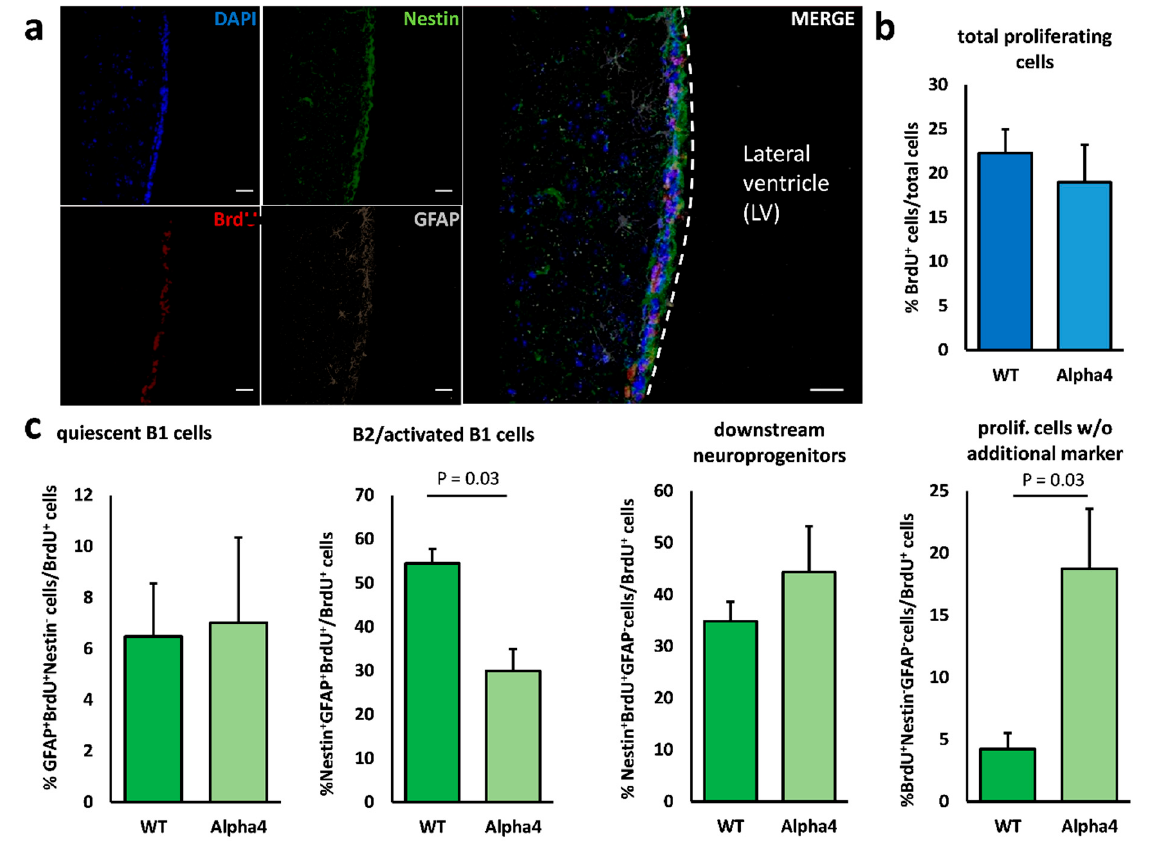
Figure 2. Neurogenesis in the V–SVZ of the L’S hypersensitive α 4* nAChR mouse. ( a ) Representative fluorescence image of the ventricular–subventricular zone lining the lateral ventricle. Daily BrdU injections over 3 days labelled proliferating cells (red). To differentiate between the various cell types within the V–SVZ, quadruple immunostainings revealed GFAP + /nestin − (grey) quiescent type B1 cells, nestin + /GFAP − (green) type A and C cells (downstream neuroprogenitors) and GFAP + /nestin + B2/activated B1 cells. Cell nuclei were counterstained with DAPI (blue). ( b ) Quantitative immunohistochemistry revealed no difference in the total number of proliferating, i.e., BrdU-incorporating, cells between wild-type and m[A30P]h α synuclein mice. ( c ) In addition, we analyzed the relative proportion of the proliferating cell types in the V–SVZ and found a significant reduction in the population of B2/activated B1 neural stem cells. In addition, the proportion of marker-negative proliferating cells (nestin − GFAP − BrdU + ) was significantly increased in mutant animals. The proportion of downstream progenitor cells, i.e., type A and C cells, was not significantly altered. Scale bar = 50 μ m. All data are presented as mean ± standard error of the mean (S.E.M.); n = 4 each. Abbreviations: LV—lateral ventricle; WT—wild-type;